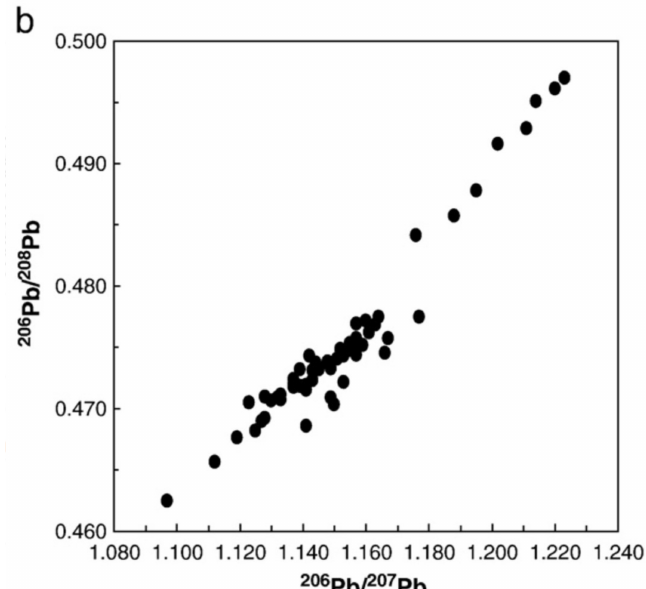
Figure 10. ( a ) 208 Pb/ 204 Pb versus 206 Pb/ 204 Pb and ( b ) 206 Pb/ 208 Pb versus 206 Pb/ 207 Pb for Northern Hemisphere atmospheric aerosols [37]. Only plotted are data for which individual analyses were presented by Bollhöfer and Rosman [37]. Sites for which ranges of Pb isotope composition were presented are omitted to avoid the possibility of plotting pairs of ratios that do not correspond to the same sample. (From